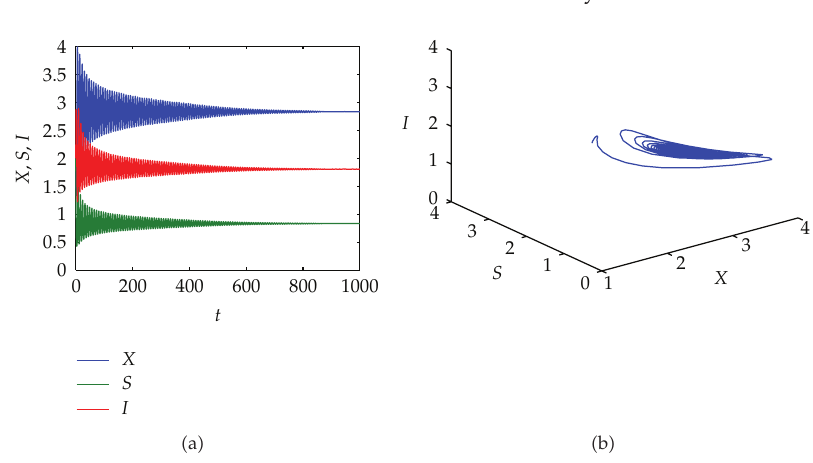
Figure 1: When τ (cid:5) 1 . 11 < τ 0 , the positive equilibrium E (cid:8) (cid:5) (cid:6) 2 . 8333 , 0 . 8333 , 1 . 8056 (cid:7) is asymptotically stable. (cid:6) a (cid:7) shows the trajectories graphs of the system (cid:6) 4.1 (cid:7) with initial data X (cid:6) t (cid:7) (cid:5) 2 , S 1 (cid:6) t (cid:7) (cid:5) 2 , I 2 (cid:6) t (cid:7) (cid:5) 2. (cid:6) b (cid:7) shows the phase portrait of system (cid:6) 4.1 (cid:7)